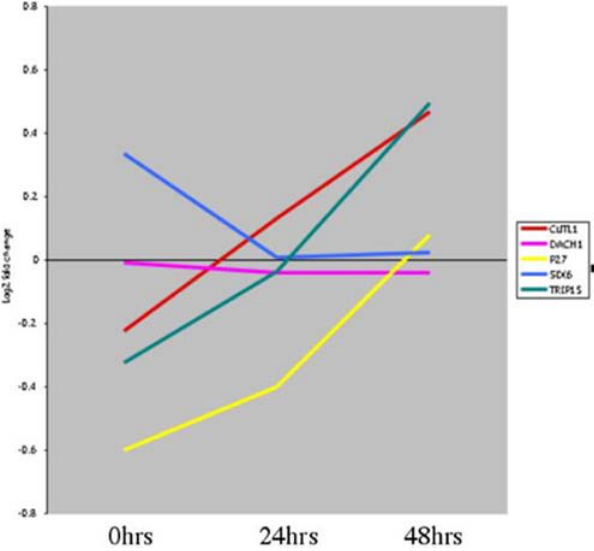
Figure 2. Gene expression changes inp27 Kip and four genes that may regulate its expression. This diagram shows a combination of semi- quantitative PCR data (for p27 Kip ) and microarray data for the other four genes conducted on the utricle neomycin time courses. Each gene expression profile is color coded with the key to the right of each figure. The X-axis lists time points and the Y-axis is the log 2 fold-change at each time point. Expression values are derived from Supplementary Table S2, except for DACH1 which is detectably expressed, but is not significantly differentially expressed across the time course.